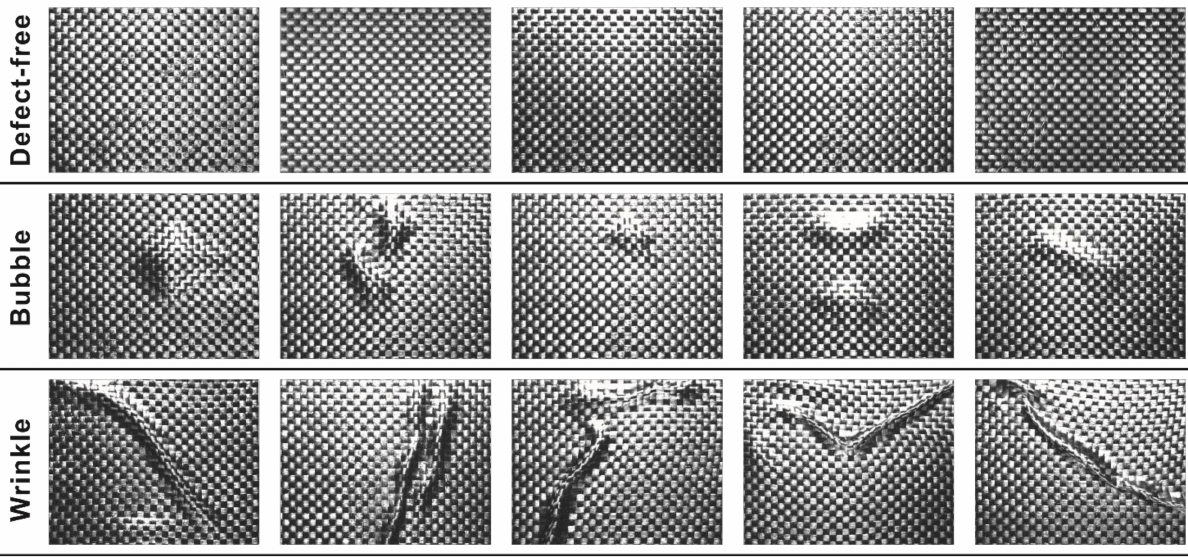
Figure 4. The original images of carbon fiber plain-woven prepreg with and without defects, captured by digital